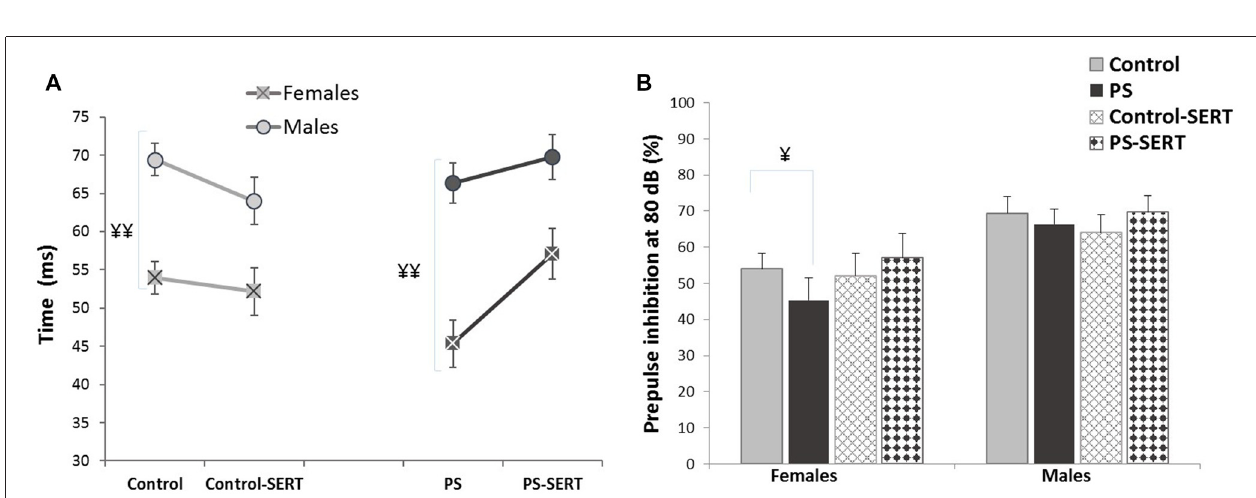
FIGURE 2 | PPI latency (A) and PPI values (B) , obtained in the animals of both sexes at the age of 90 days, previously submitted or not to prenatal stress (PS and Control) and treated with SERT (5 mg/kg/day; PS-SERT and Control-SERT). n = 9–14 animals per group and sex (Mean values ± SEM). (cid:85)(cid:85) p < 0.01 and (cid:85) p < 0.05 indicate a main effect of